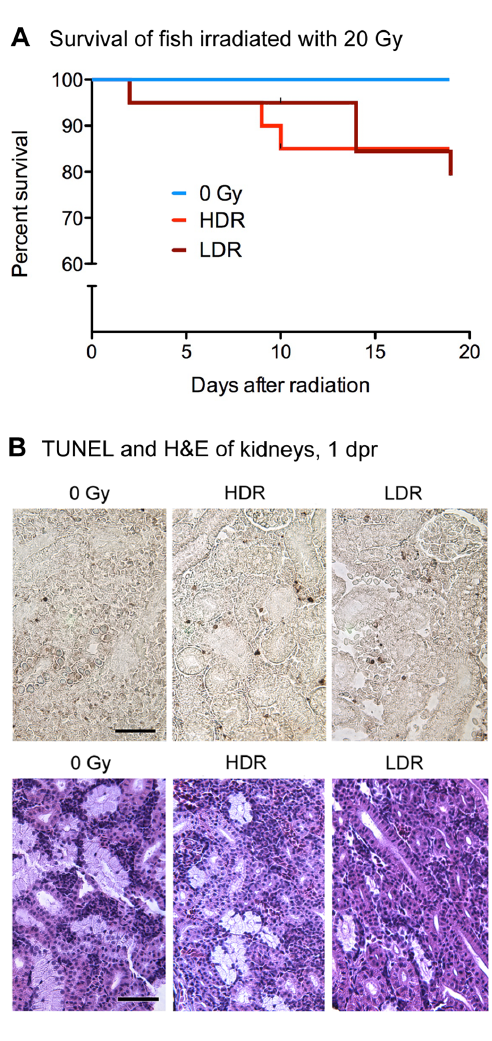
Figure 1. Consequences of 20Gy at 25 cGy/min vs 800cGy/min in non-transplanted fish. A, Kaplan-Meier survival curves of adult zebrafish irradiated with 20Gy at either 25cGy/min (LDR) or 800cGy/min (HDR). Pooled data from two independent trials, each trial composed of ten fish per group. p=.356 (Log Rank Test). B, TUNEL staining (above), and H&E staining (below) of adult zebrafish kidneys harvested one day after 20Gy radiation delivered at either 25cGy/min or 800cGy/min.